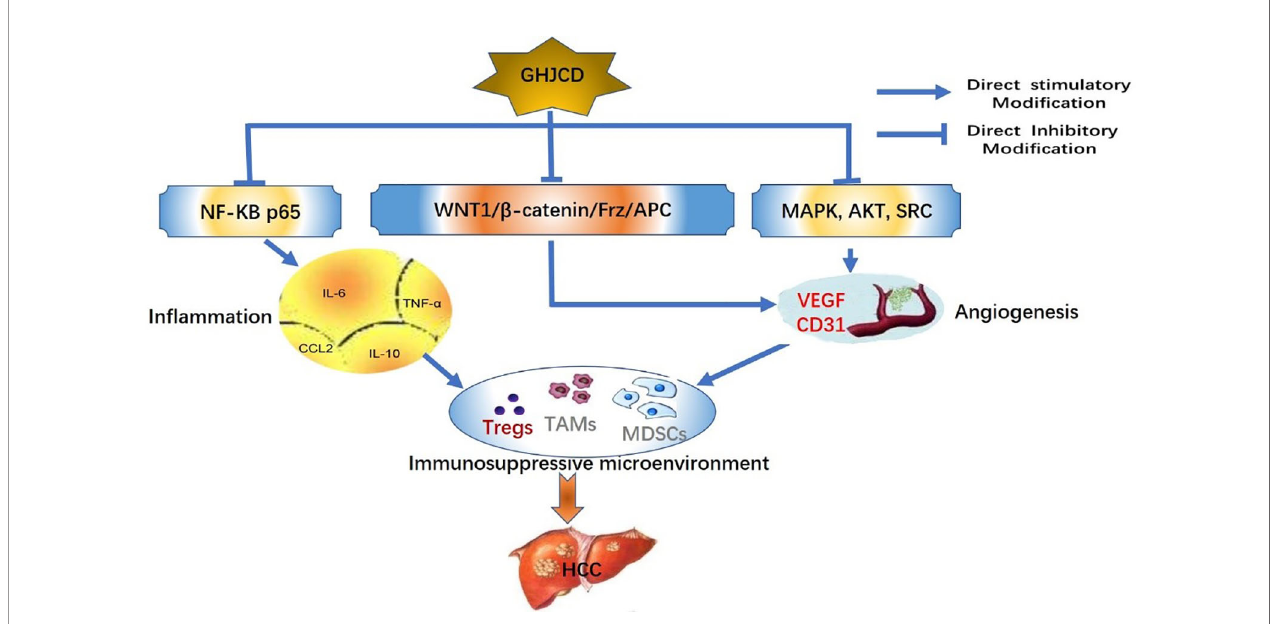
FIGURE 7 | GHJCD inhibits HCC pathway by improving tumor